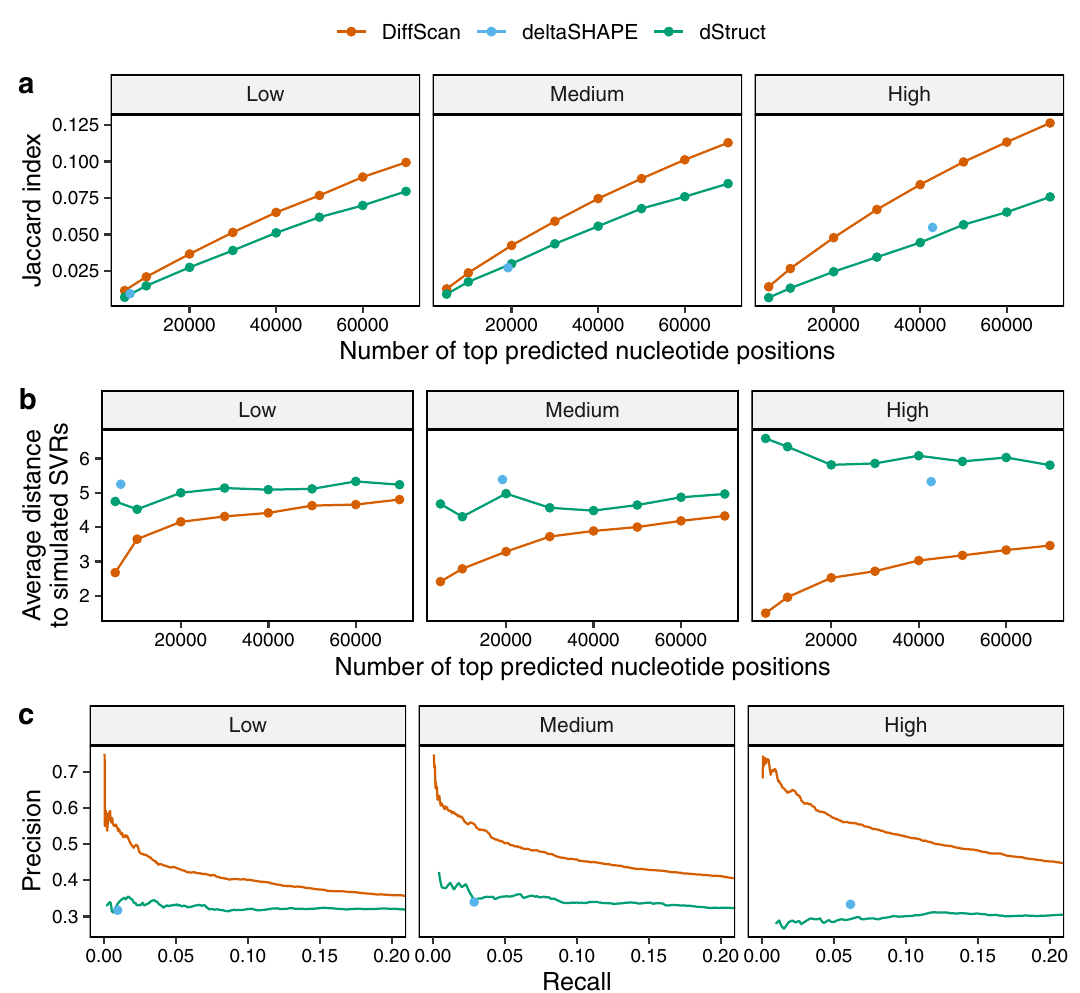
Fig. 2 Comparison of DiffScan and existing SVR detection methods in simulated datasets. Default search length of 5 nt is used for deltaSHAPE and minimum search length of 5 nt is used for dStruct. The empirical model in Sükösd et al. 40 was used to simulate reactivities. a Jaccard index between the top predicted nucleotides and the true SVRs at varying cutoffs. b Average distance between the top predicted nucleotides and the true SVRs at varying cutoffs. c Precision-Recall curves. Columns: three levels of strength of differential signals at simulated SVRs. Note deltaSHAPE does not allow external thresholding, and therefore it is represented as dots instead of